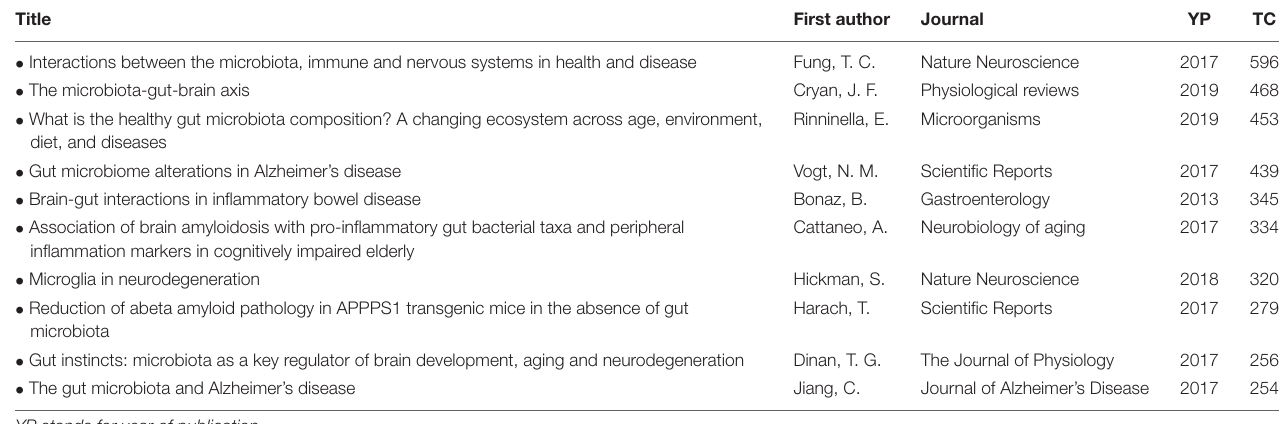
TABLE 4 | Publications with the highest number of citations.